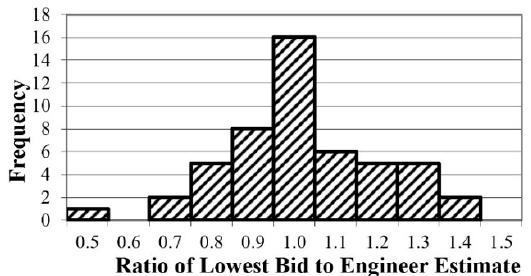
Figure 6. Lowest bid distribution using ratio to engineer’s estimate.